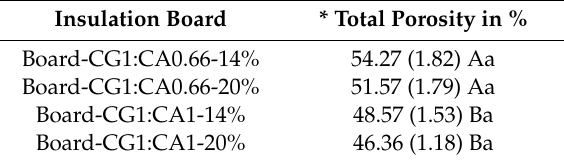
Table 8. Percentage of porosity of wood fiber insulation boards.